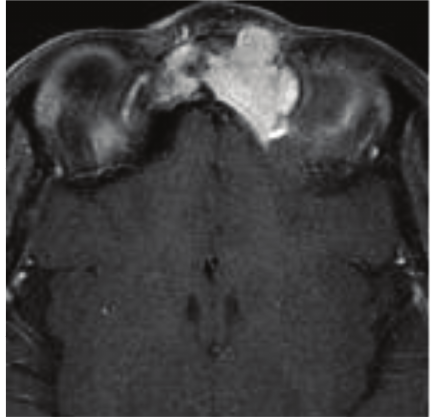
Figure 4: Preoperative axial MRI image of the tumor.